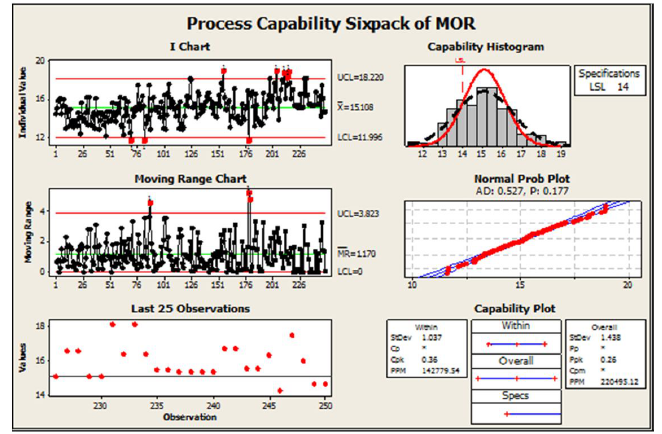
Fig.3. Process capability of MOR before